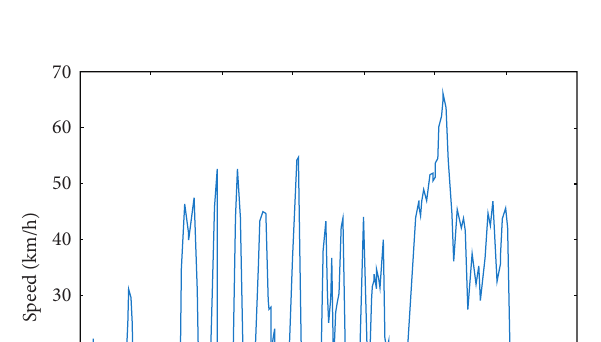
Figure 10: Driving cycle 1.